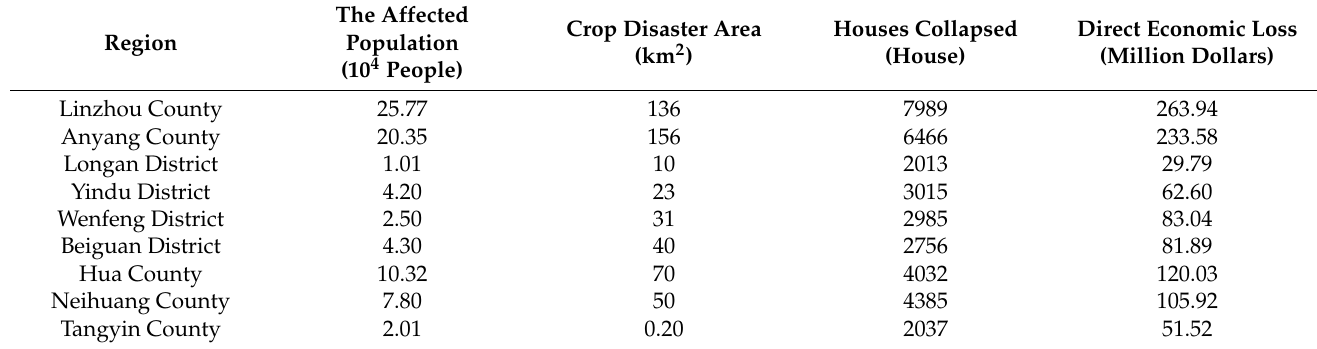
Table 8. Anyang Region flood disaster loss situation table in